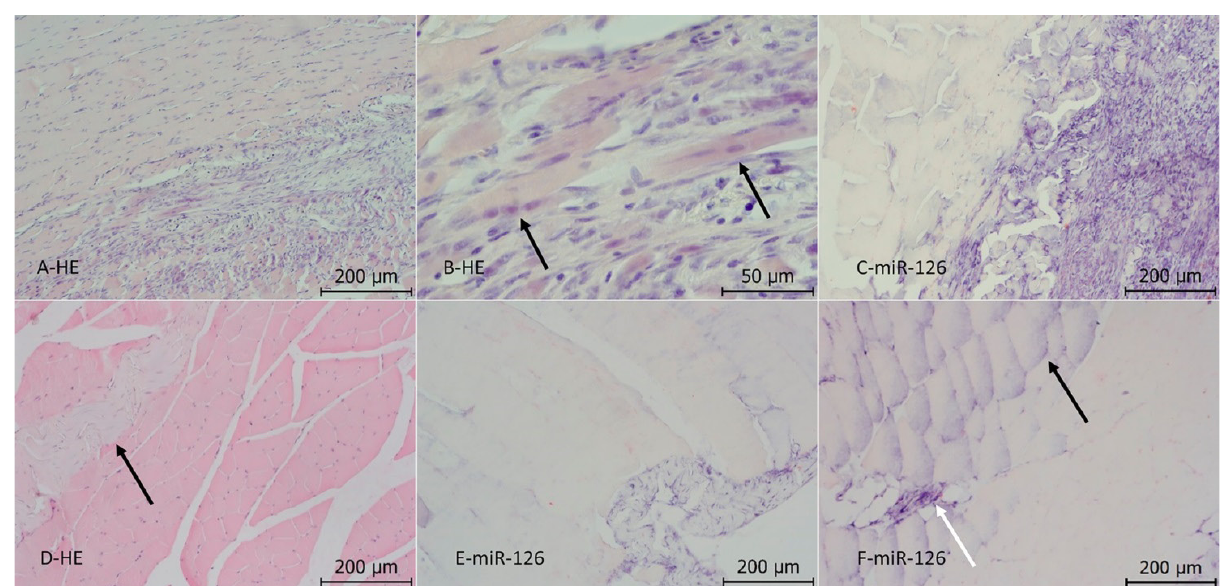
Fig. 1. Histological evaluation of the healing phases and miR-126 detection with in situ hybridization. (A) Early phases of heal- ing with a necrotic field and granulation tissue (hematoxylin-eosin staining, magnification 100×). (B) Detail from the previous slide. Arrows show regenerating muscle tissue (magnification 400×). (C) miR-126 positivity detected with in situ hybridization in granulation tissue (magnification 100×). (D) Late phase of healing. Arrow indicates fibrous scar (magnification 100×). (E) miR-126 positivity in a fibrous scar (magnification 100×). (F) miR-126 positivity in vessels (white arrow) and regenerating muscle fibres (black arrow) (magnification 100×).